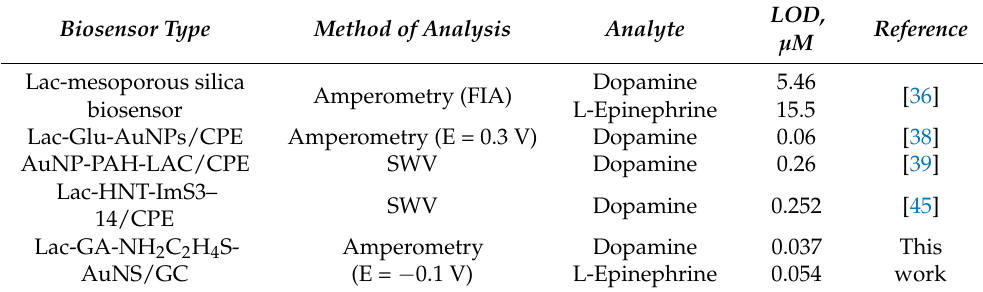
Table 3. Comparison of detection limits for some recently reported laccase-based biosensors for dopamine.